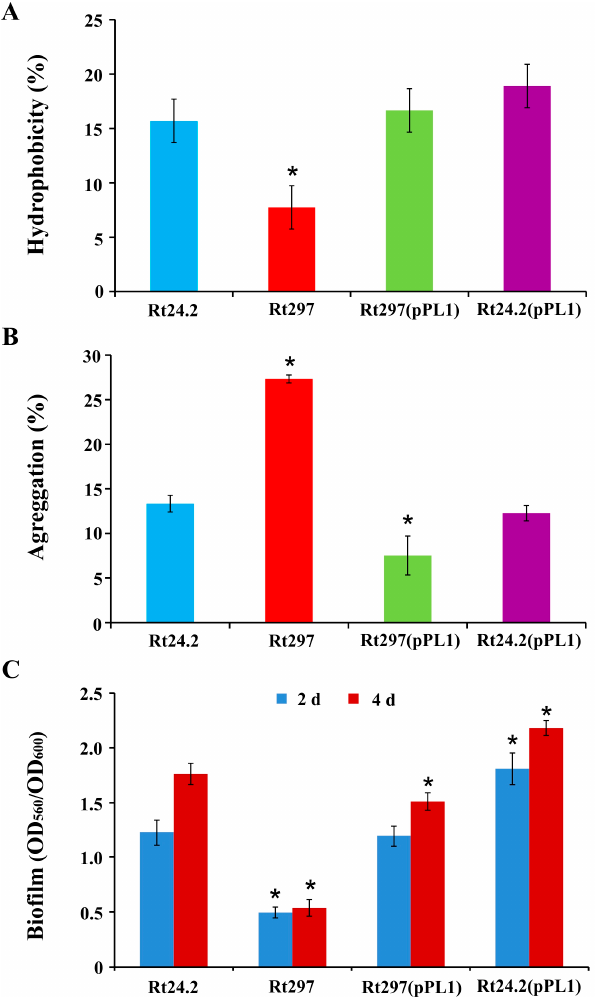
Figure 7. Cell hydrophobicity ( A ), aggregation ability ( B ), and biofilm formation ( C ) by the wild-type strain R. leguminosarum Rt24.2 and its derivatives. The values are averages ± SD of two independent experiments with three biological replicates for each strain analyzed. * Significant difference between Rt24.2 and the remaining strains submitted to a given treatment ( p < 0.05, Student’s t -test).